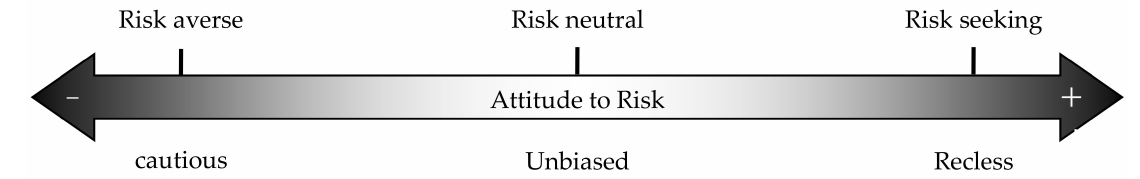
Figure 1. Characteristics of risk preference